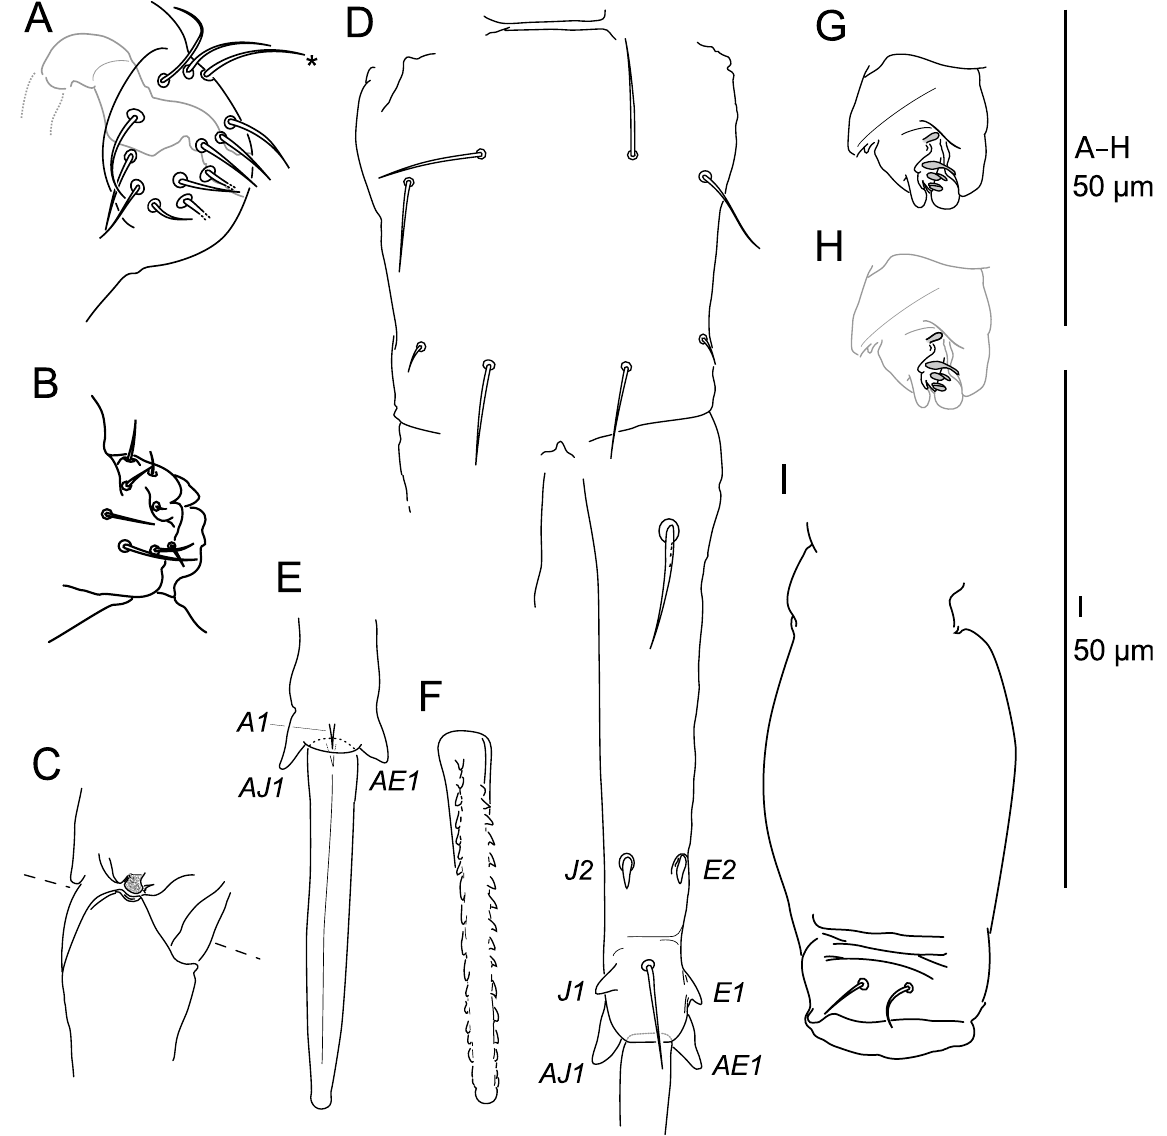
Fig. 6. Spinaethorax adamantis sp. nov. A–B . Male sexual apparatus. A . Male genital plate (asterisk indicates a chaeta not seen on other side, possibly unpaired). B . Immature male genital plate. C . Manubrium/ dens anterior articular process. D . Chaetotaxy of manubrium and dens posterior side. E . Distal part of dens and mucro anterior side. F . Mucro posterior side. G–H . Tenaculum. H . Focused on apical teeth and basal process. I . Ventral tube lateral